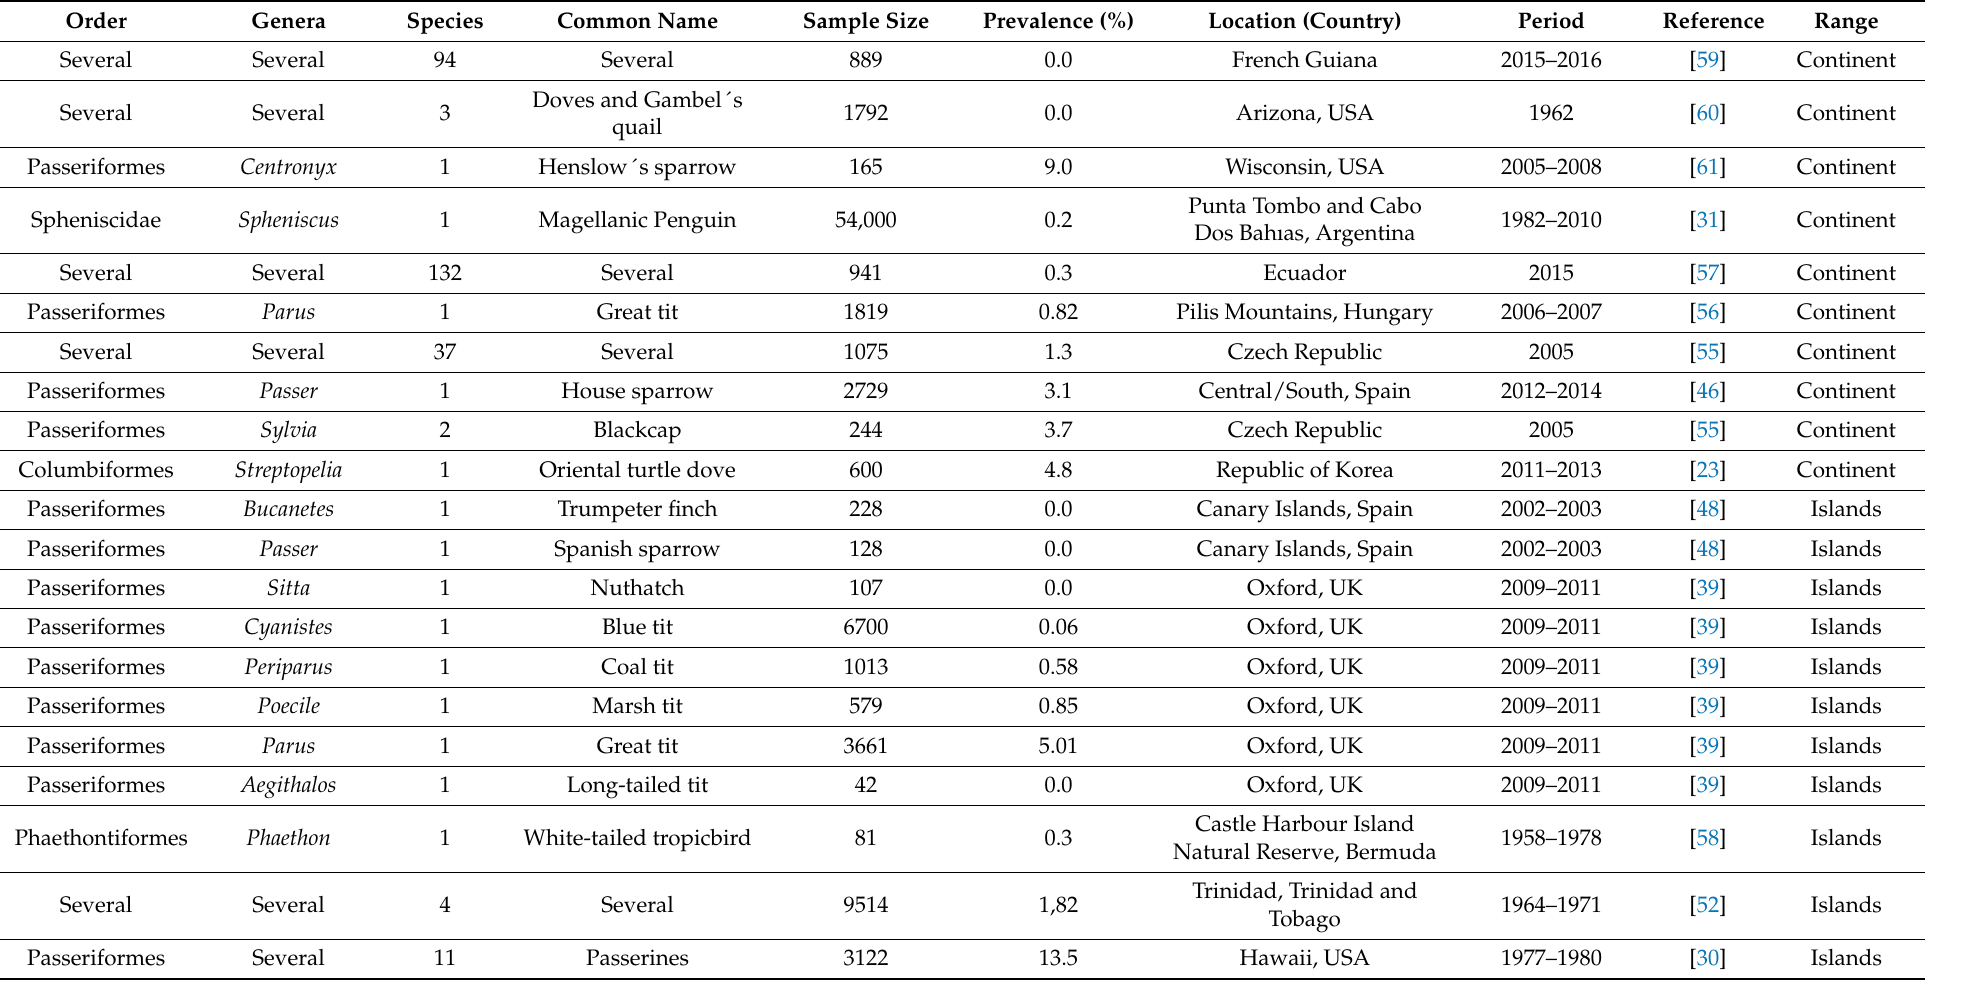
Table 1. Prevalence of avian poxvirus in surveys that are not identified by authors as epizootics or